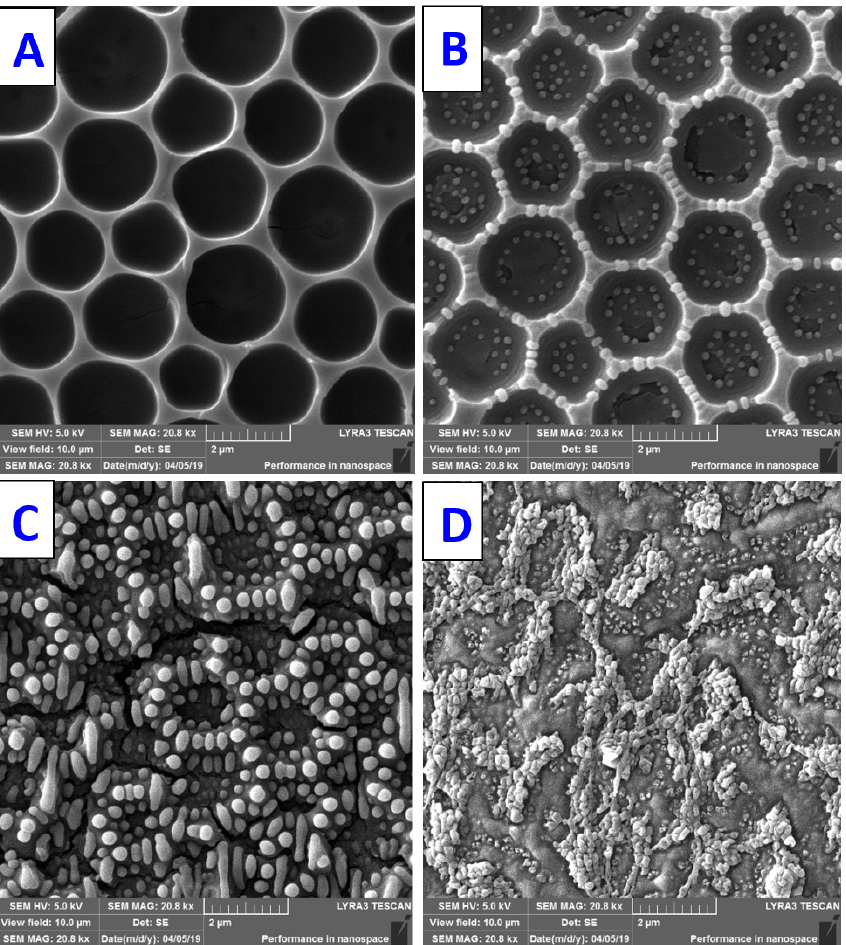
Figure 11. The different stages of modification of honeycomb-like PS patterns prepared on a FEP substrate plasma exposed to 8 W and 240 s (2 g of PS, ratio 90/10). The polystyrene HCP structures were exposed to an excimer laser with 6000 counts and laser fluence: ( A )—0, ( B )—6 ( C )—10 and ( D )—20 mJ.cm − 2 [22].